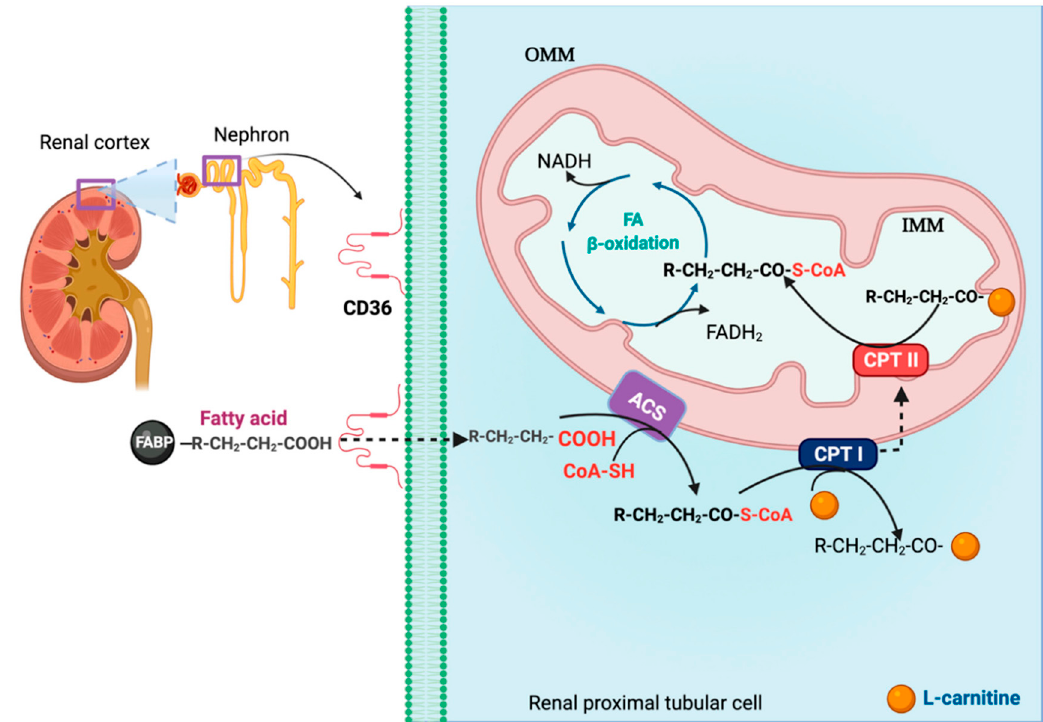
Figure 3. Renal proximal tubule (RPTC) cells use fatty acids (FA) β -oxidation to produce adenosine triphosphate (ATP). In the kidney, the proximal tubules of the nephrons of the renal cortex use fatty acids (FA) as the primary source of energy. FA bound to the fatty acid-binding protein (FABP) enter the RPTC through the cluster of differentiation 36 (CD36). In the cytosol, acyl-coenzyme A (CoA) synthetase (ACS) (attached to the outer mitochondrial membrane (OMM)) activates FA by the addition of acetyl-CoA (CoA-SH). The latter allows FA to enter the OMM through carnitine O -palmitoyl transferase I (CPT I). CPTI exchanges acetyl-CoA for L-carnitine. In turn, FA goes to the inner mitochondrial membrane (IMM). In the IMM, carnitine O -palmitoyl transferase II (CPT II) removes the carnitine group and adds acetyl-CoA (CoA-SH). The latter allows FA to enter the mitochondrial matrix. Fatty acyl-CoA undergoes β -oxidation, generating nicotinamide adenine dinucleotide phosphate (NADH) and flavin adenine dinucleotide (FADH 2 ). Created with Bioren- der.com .